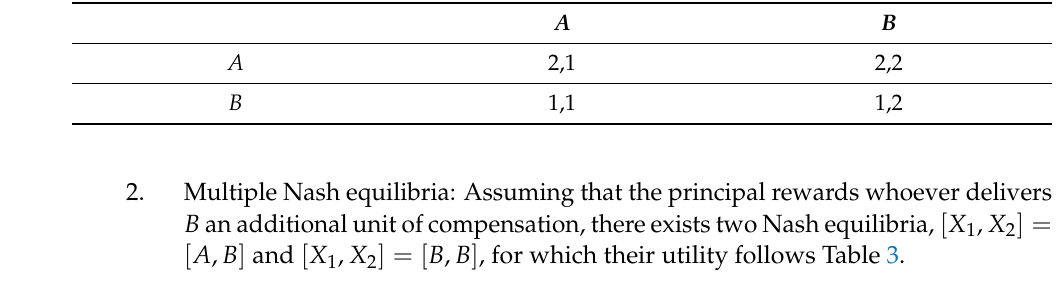
Table 3. Agents’ output with multiple Nash equilibria.